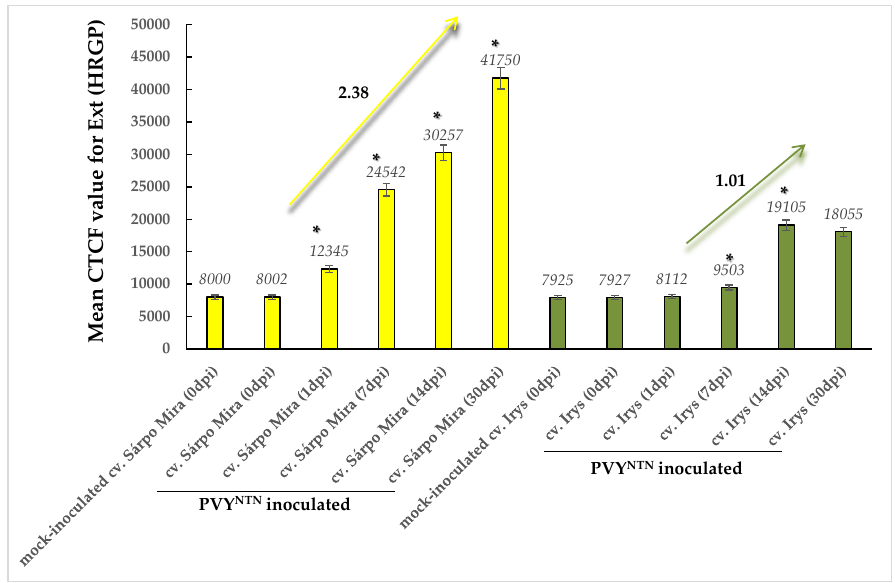
Figure 8. The quantitative fluorescence signal of extensins (HGRPs) was performed using the corrected total cell fluorescence method (CTCF) in combination with ANOVA. The yellow charts represent mock-inoculated and PVY-inoculated S á rpo Mira (resistant) potato plants at 0, 1, 7, 14, and 30 dpi. The yellow arrow represents an increase in the fluorescent signal value between 1 and 30 dpi in virus-infected S á rpo Mira plants. The dark green charts represent mock- and PVY NTN -inoculated Irys (susceptible). The dark green arrow represents an increase in the fluorescent signal value between 1 and 14 dpi in virus-infected Irys plants. Mean values of CTCF were evaluated at the p < 0.05 level of significance using the post-hoc Tukey HSD test. Statistically significant values after mock or virus inoculation are marked by asterisks (*) above the mean value of the CTCF on each